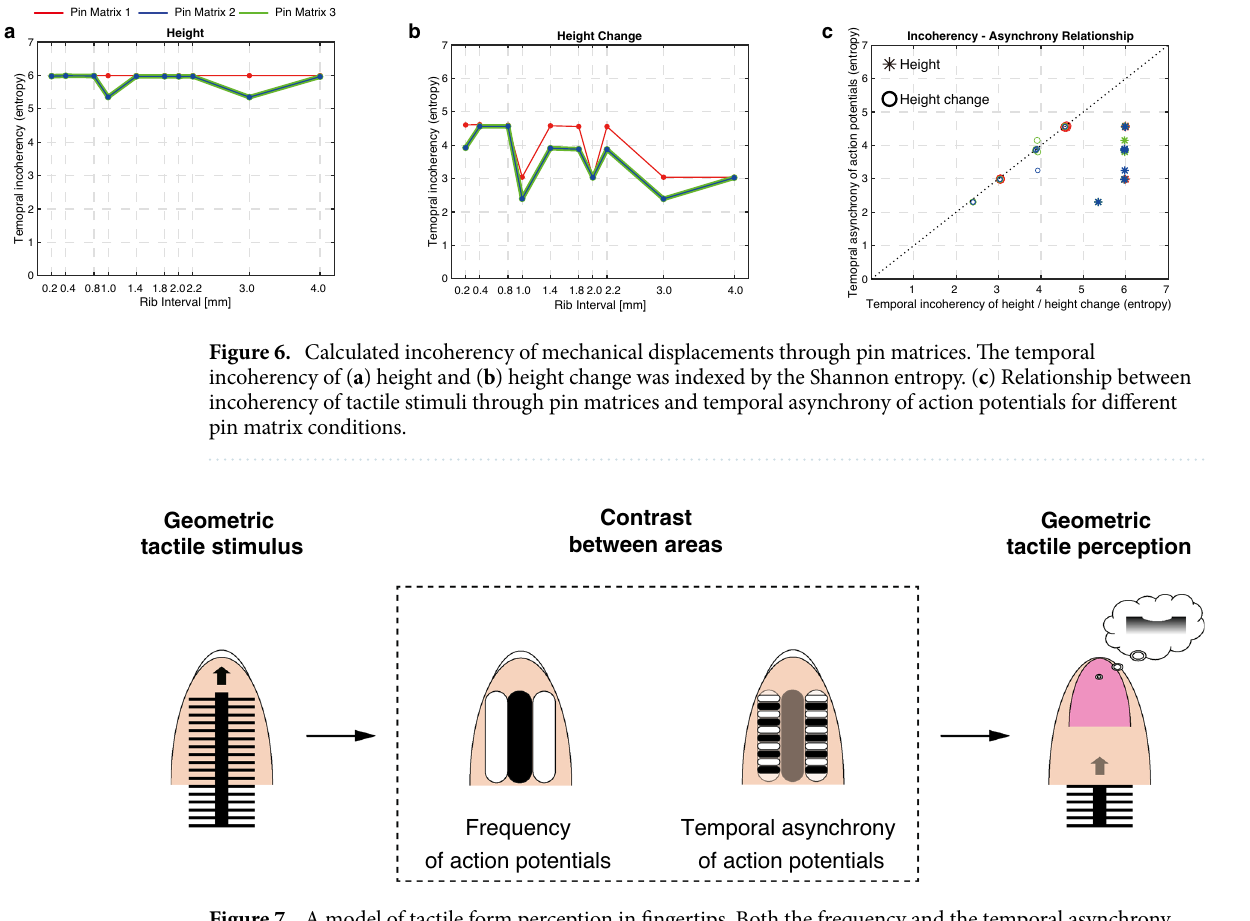
Figure 7. A model of tactile form perception in fingertips. Both the frequency and the temporal asynchrony of action potentials may contribute to tactile form perception. If the temporal asynchrony of action potentials were to decrease, a perceiver would report attenuated depth of perceived surface indentation at the backbone of fishbone patterns.